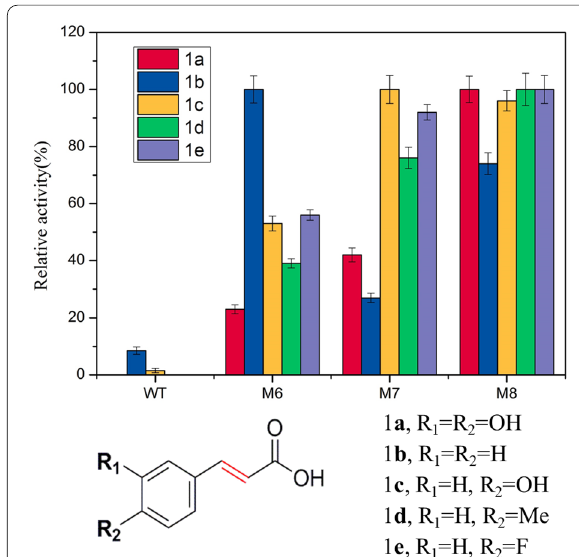
Fig. 3 Activity fingerprints of Ec MAL and its variants (M6–M8) with different substrates. The activity was measured by HPLC, and relative activity is measured as a percentage of the optimum activity of each substrate ( 1a caffeic acid, 1b cinnamic acid, 1c p ‑hydroxycinnamic acid, 1d methylcinnamic acid, 1e acrylic acid)